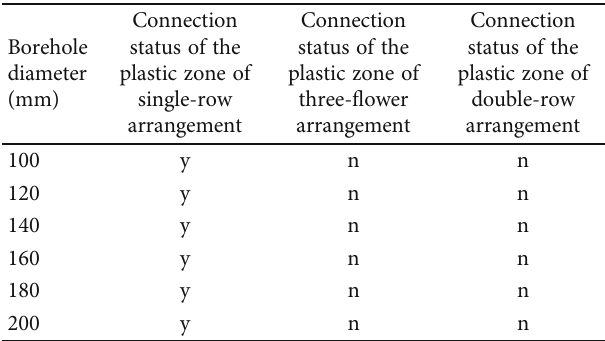
Table 3: Plastic zone connection of pressure relief boreholes with di ff erent